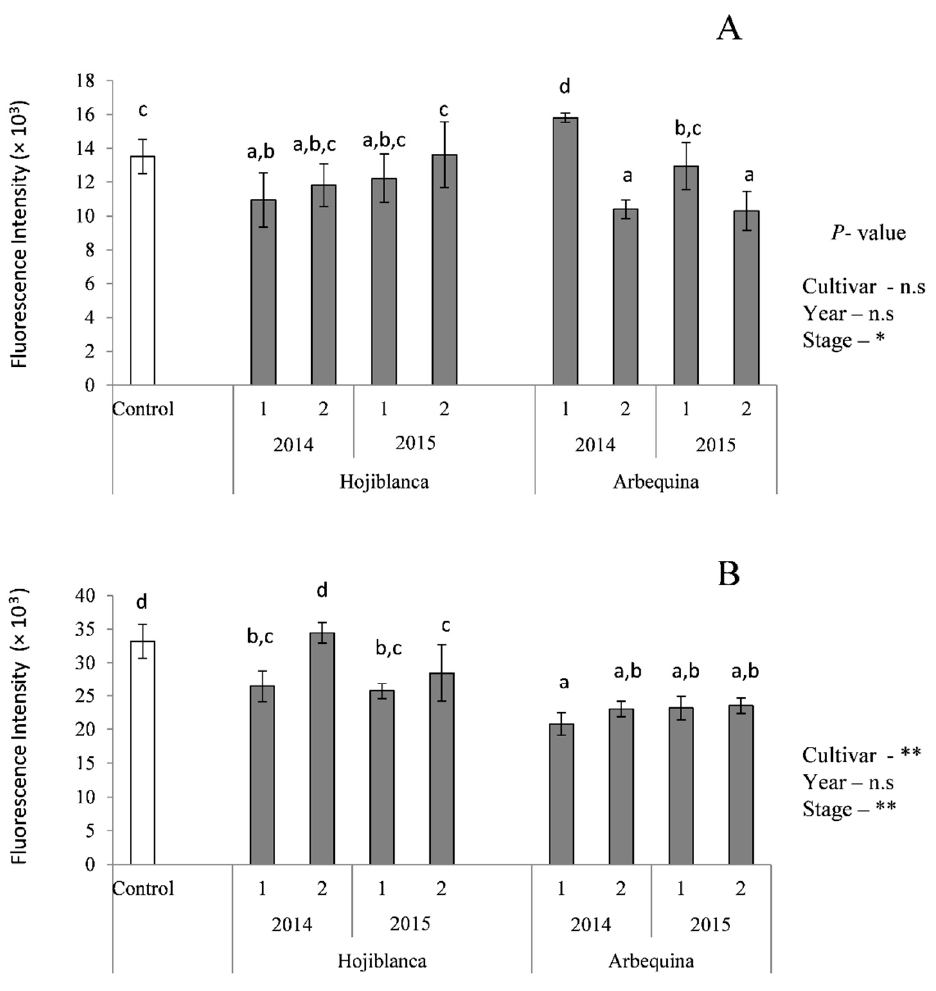
Figure 2. Reactive oxygen species (ROS) generation in Caco-2 cells expressed as fluorescence intensity at 90 minutes after incubation concerning the basal ( A ) and protective effect ( B ) oxidized with t-BOOH 5 mM. The control cells were incubated with culture medium only. n.s: P > 0.05; * P < 0.05; ** P < 0.01. Different letters indicate significant differences within samples and controls ( P <